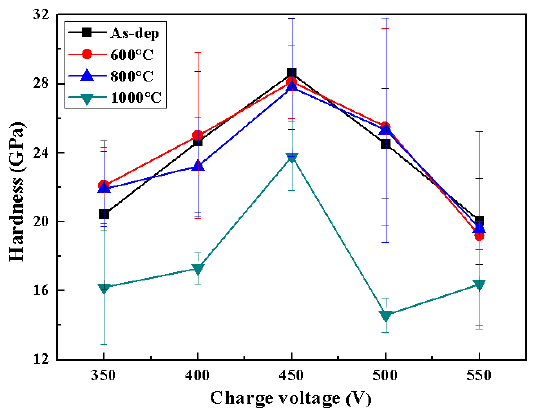
( d ) Figure 8. The cross ‐ sectional SEM micrographs of the vacuum annealed AlCrN coatings deposited at the AlCr target charge voltage of ( a , b ) 450 V and ( c , d ) 500 V after vacuum annealing for 2 h at ( a , c ) 800 °C and ( b , d ) 1000 °C. As shown in Figure 9, when the vacuum annealing temperature was below 800 °C, the hardness values were almost the same as those of the as ‐ deposited coatings. This suggests that the AlCrN coatings maintained thermal stability at temperatures below 800 °C, which is consistent with both the XRD results (Figure 7) and the SEM results (Figure 8). Similar results were reported by Feng et al. [33] and Lin et al. [34]: Hardness of the AlCrN coatings drops substantially at temperatures higher than